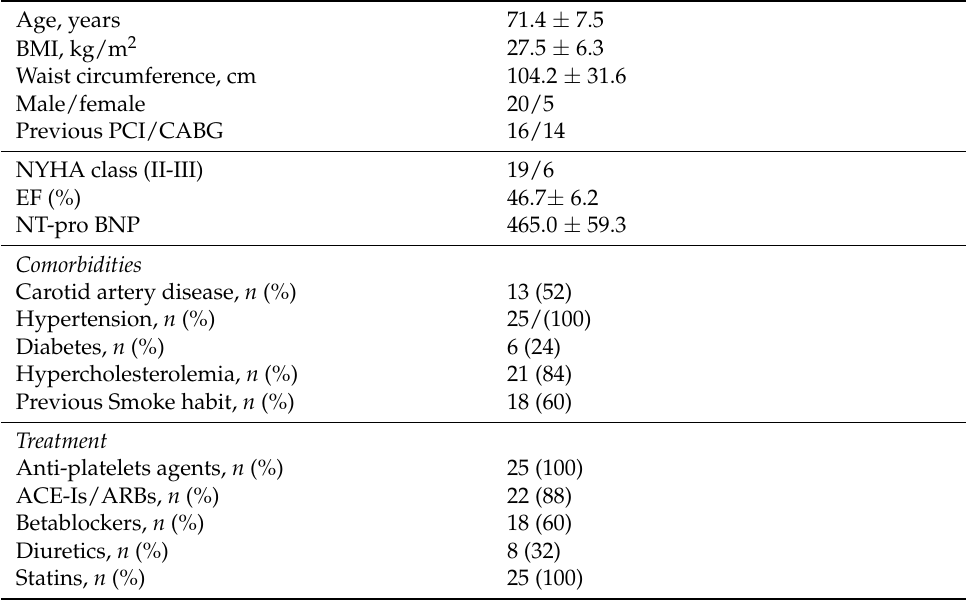
Table 1. Anthropometric and clinical characteristics of